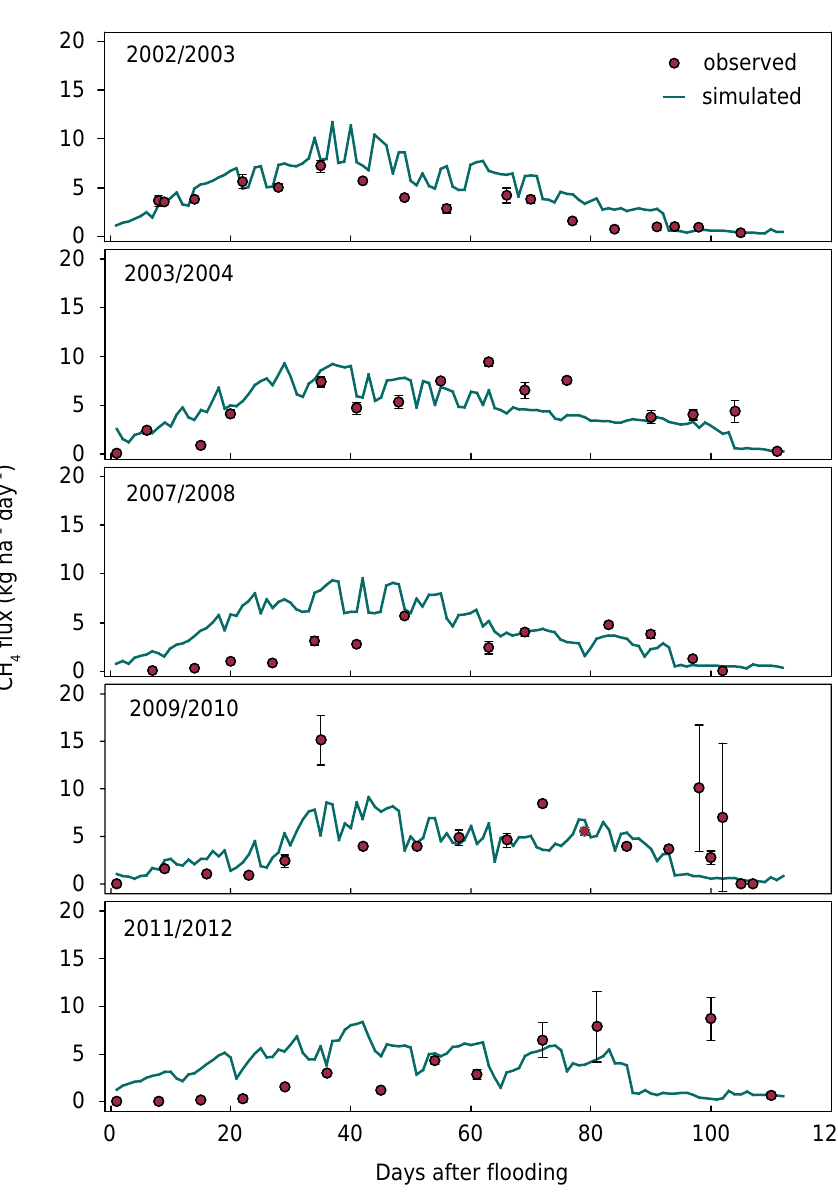
Figure 4. Simulated and observed daily soil methane (CH 4 ) fluxes in paddy fields under a no-tillage system in a long-term experiment in southern Brazil. Error bars represent standard